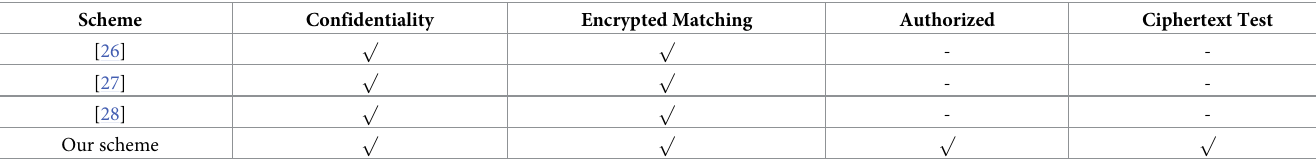
Table 7. The comparison with other schemes.